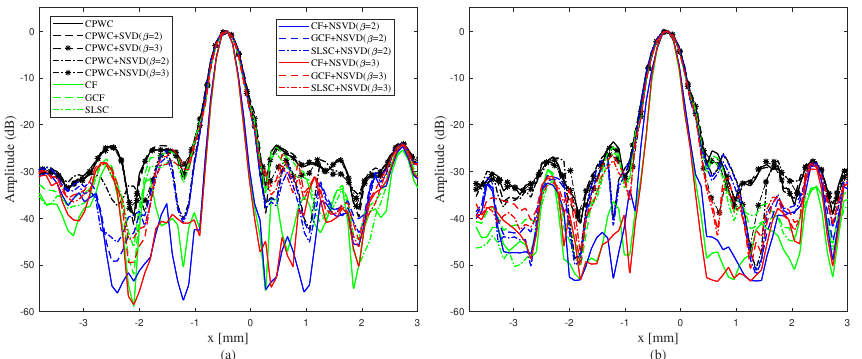
Figure 9. The lateral profiles of two experimental point targets positioned at ( a ) p 1 ( x , z ) = ( − 0.4 mm, 18 mm), ( b ) p 2 ( x , z ) = ( − 0.4 mm, 38